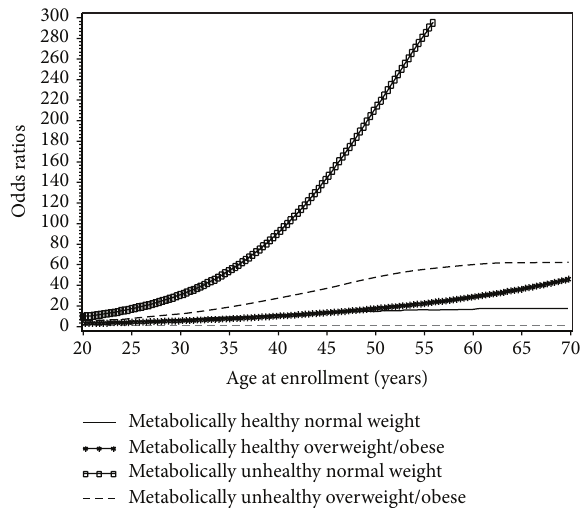
Figure 2: Smoothed plot for odds ratios (ORs) of the diabetes risk according to age at enrollment. Subjects were divided into four phenotypes according to overweight/obese phenotype and metabolic health status. The ORs were estimated by using the restricted cubic spline logistic regression models with knots placed at the 5th, 50th, and 95th percentiles of age at enrollment. The models were adjusted for the probability of sampling using weights taking into consideration clustering effects arising from the same census block and household. The linear correlation between age at enrollment and the risk of diabetes in each phenotype was significant ( 𝑃 = 0.02 , 0.0001, 0.04, and < 0.0001 for phenotypes with metabolically healthy normal weight, metabolically healthy overweight/obesity, metabolically unhealthy normal weight, and metabolically unhealthy overweight/obesity,